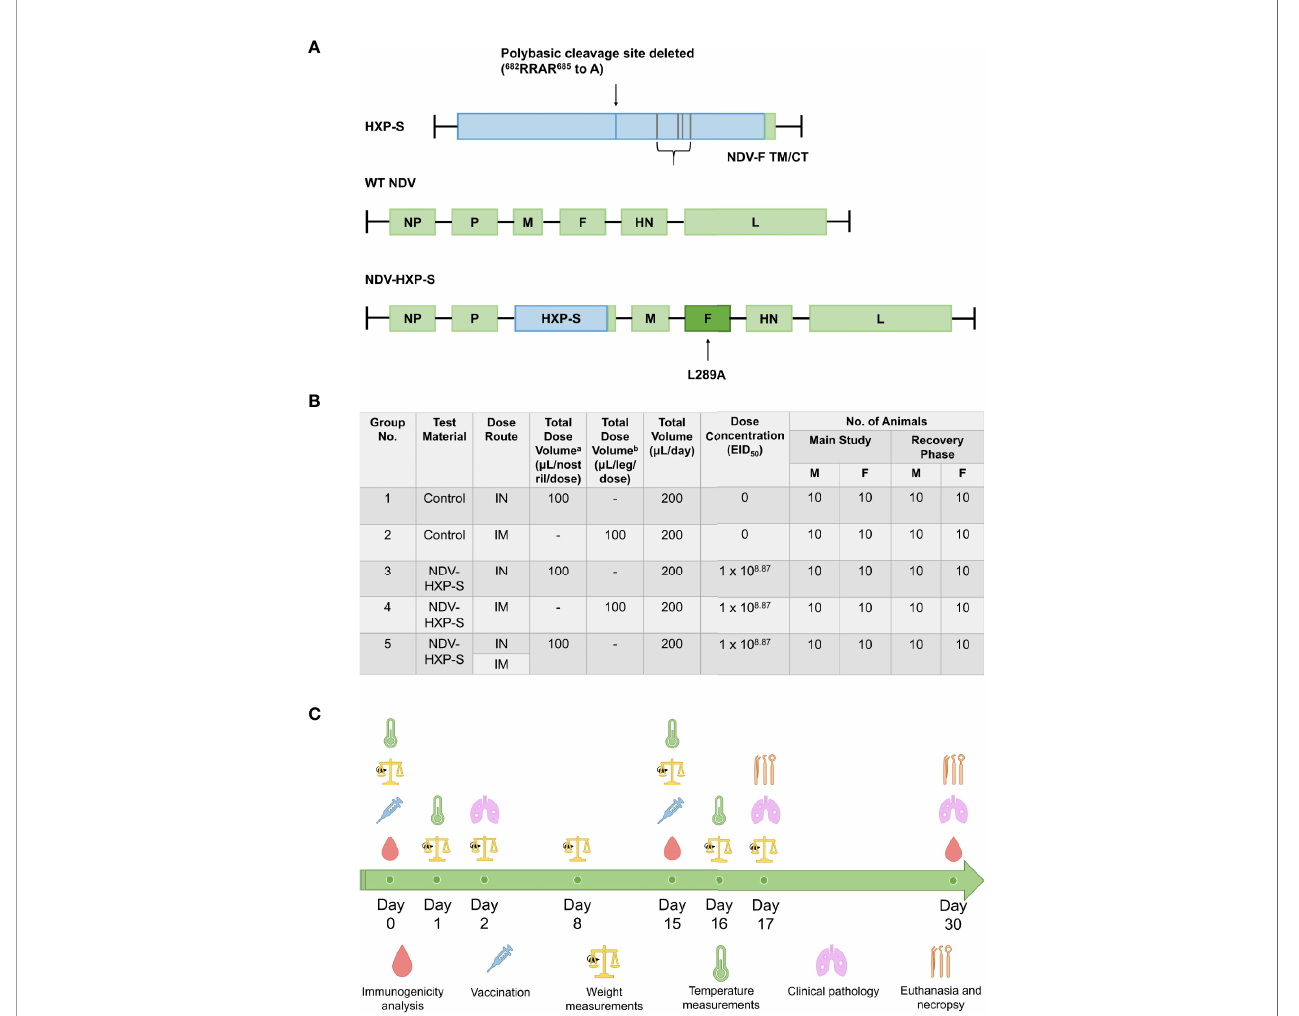
FIGURE 1 | Schematic representation of NDV-HXP-S production and testing in rats. (A) Vector design. The S/F chimera was created by fusing the spike protein ectodomain (S), containing HexaPro stabilizing mutations, to the transmembrane domain and cytoplasmic tail (TM/CT) of the Newcastle Disease Virus (NDV) fusion (F) protein via a short GGGGS linker. The three arginines (R) in the polybasic cleavage site (RRAR) were removed to eliminate the cleavage site. The construct was termed HXP-S, which is codon optimized for mammalian expression. The HXP-S nucleotide sequence was incorporated between the P and M genes of the La Sota NDV genome carrying the L289A mutation in the F protein. (B) Groups distribution. Rats were separated into fi ve groups: intranasal (IN) control (group 1), intramuscular (IM) control (group 2), IN vaccinated (group 3), IM vaccinated (group 4), and IN-IM vaccinated (group 5). Rats receiving the vaccine by uneven administration routes fi rst received the intranasal dose at day 0, followed by the intramuscular dose at day 15. Intranasal dose volume was administered to each nostril twice at 50 µL/occasion, 30 ± 5 minutes apart, for the total dose volume of 100 µL/naris, or 200 µL total. Intramuscular dose volume was administered to the thigh muscles of both hind legs, for the total dose volume of 100 µL/leg, or 200 µL total. (C) Experimental design. All the groups received a vaccine prime at day 0 followed by a boost at day 15. Serum samples were collected for immunogenicity analyses at days 0, 15, and 30 after the fi rst vaccine dose administration. Weight measurements were performed on days 0, 1, 2, 8, 15, 16, and 17 post-vaccination. Body temperatures (°C) were measured at 0-, 6- and 24-hours post-dosage, after both the prime and boost vaccine administrations. Clinical pathology assessments were performed on days 2, 17, and 30 following the fi rst vaccination. Rats were euthanized on day 17 and day 30 for the main and recovery groups,